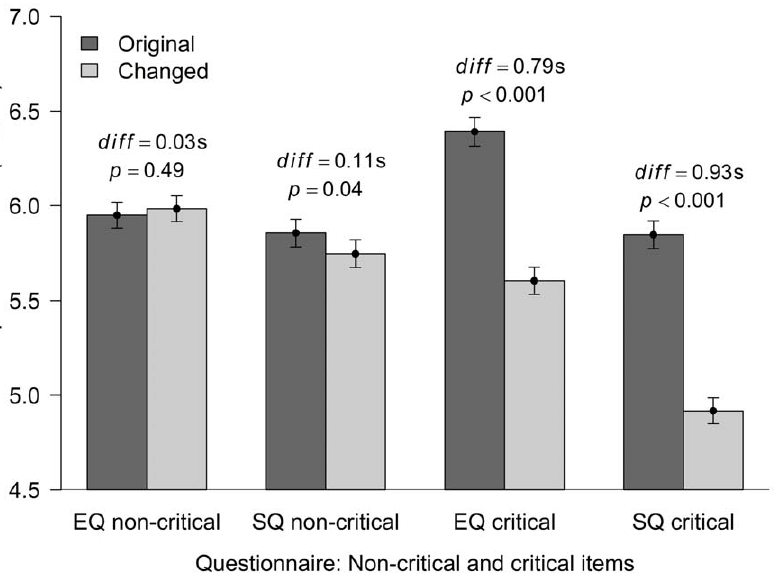
Figure 3. The mean response times for the non-critical items for EQ and SQ (which were the same items) and for the critical items for the EQ and SQ (where the original versions were negatively phrased and the changed were not).